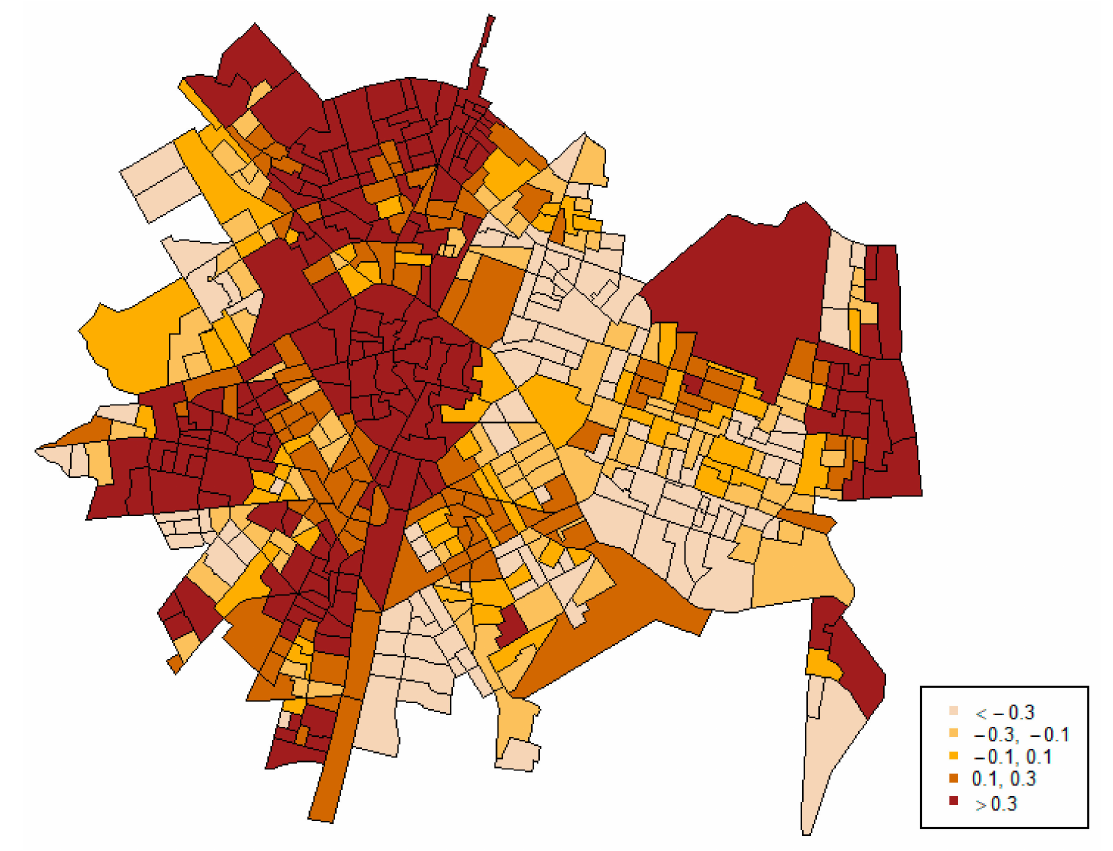
Figure 1. Shared spatial